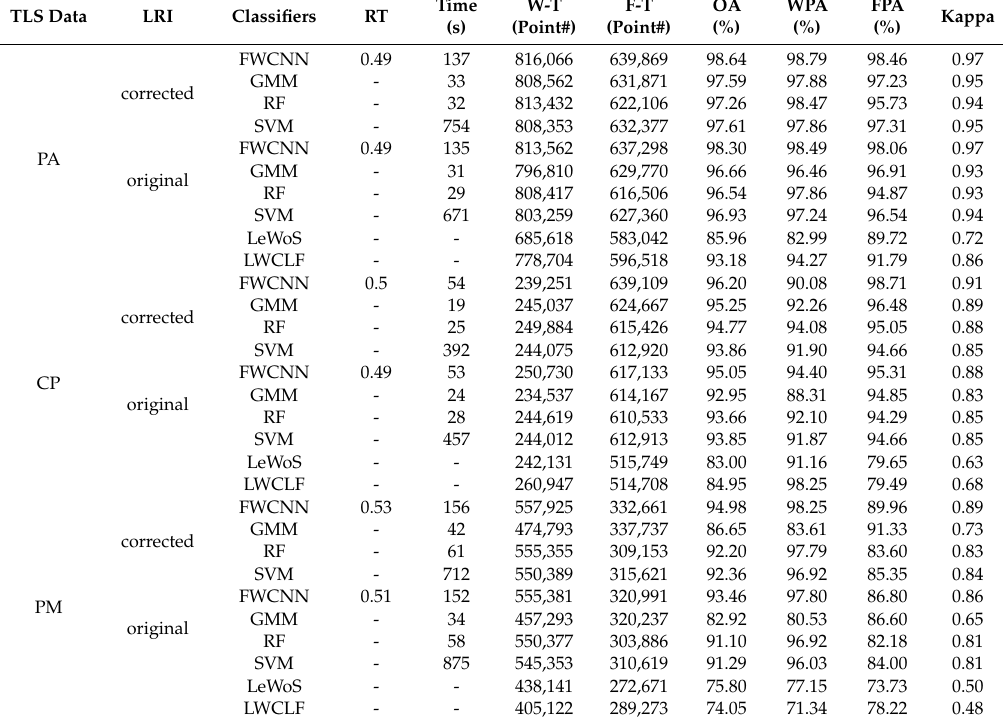
Table 2. Comparing the classification accuracy of using six types of classifiers (FWCNN, GMM, RF, SVM, LeWoS, and LWCLF) to separate woody and foliage points from (original and LRI-corrected) TLS data. Within these classifiers, the LeWoS and LWCLF models only used the geometric-based features to classify woody and foliage components from TLS data. The RT means the threshold to reclassify the pointwise classification scores analyzed by the FWCNN model. The data in the time column show the time consumption of running four types of classifiers apart from the feature extraction process. We did not list the time cost of two geometric-based models owing to their feature extraction methods were di ff erent from the other four classifiers. The F-T and W-T mean the number of foliage and woody points that were correctly classified within the test sets. The OA means the overall classification accuracy. The FPA and WPA mean the producer’s accuracy of foliage and woody points in the classification results,